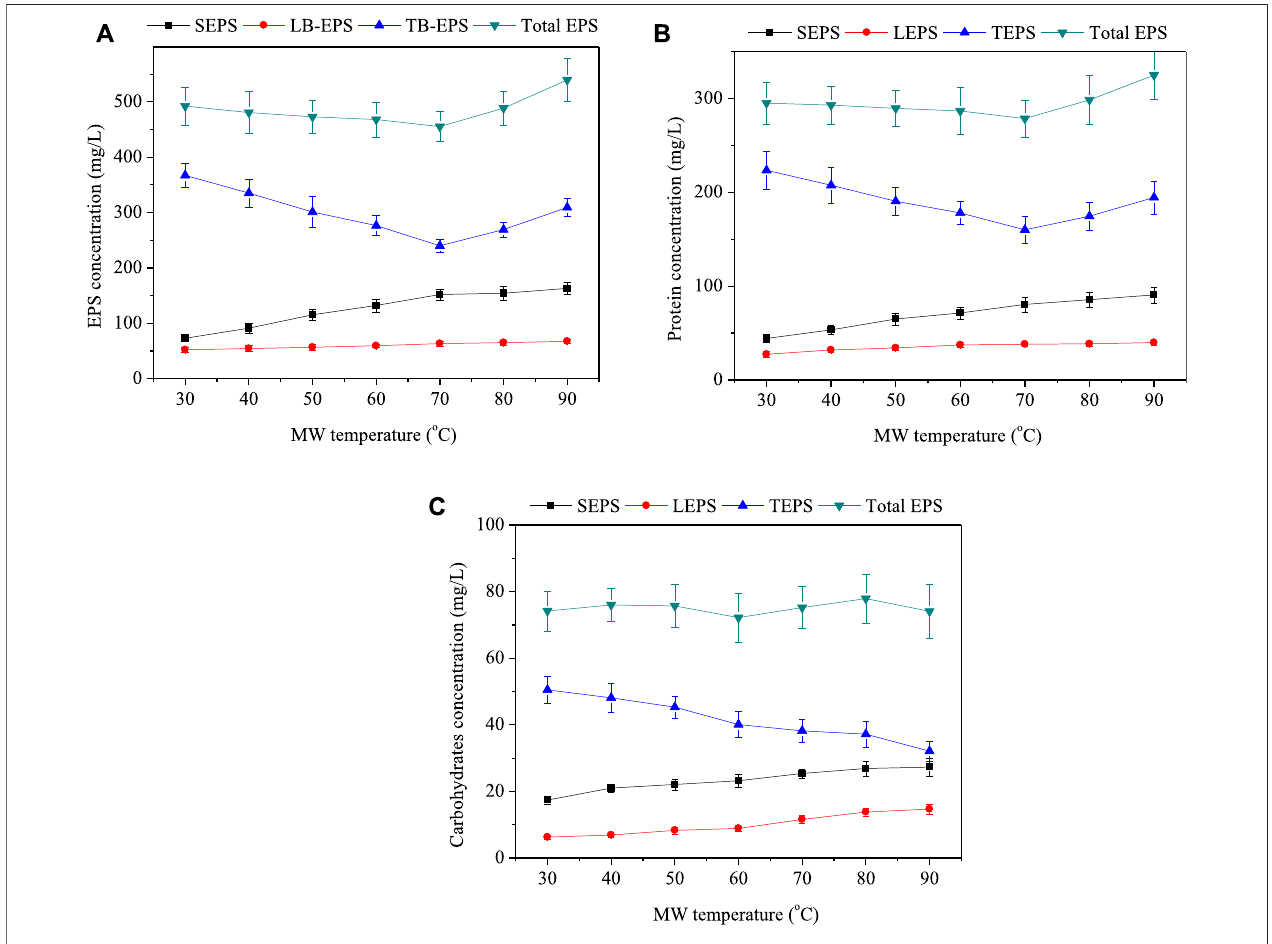
FIGURE3| VariationsofEPSconcentrationtreatedwith20 mgCaO 2 /gVSSanddifferentMWtemperatures: (A) TOCconcentrationoftheSEPS,LB-EPS,andTB- EPS; (B) protein content in SEPS, LB-EPS, and TB-EPS; (C) polysaccharide content in SEPS, LB-EPS, and TB-EPS.